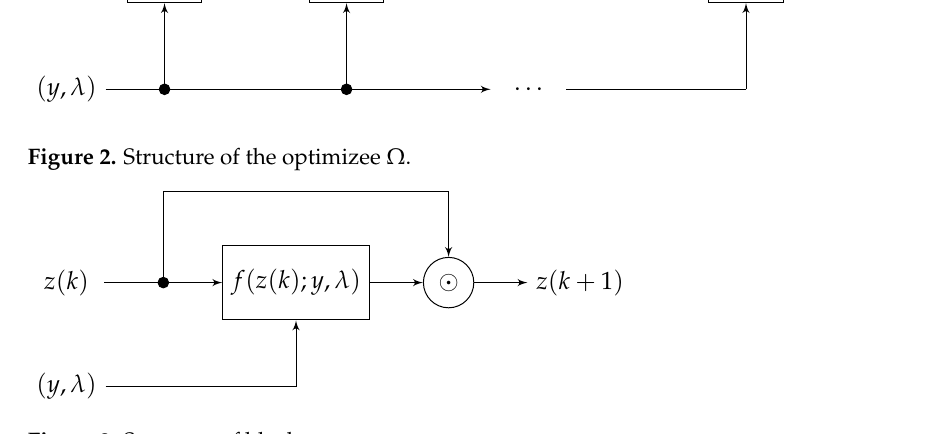
Figure 3. Structure of block p